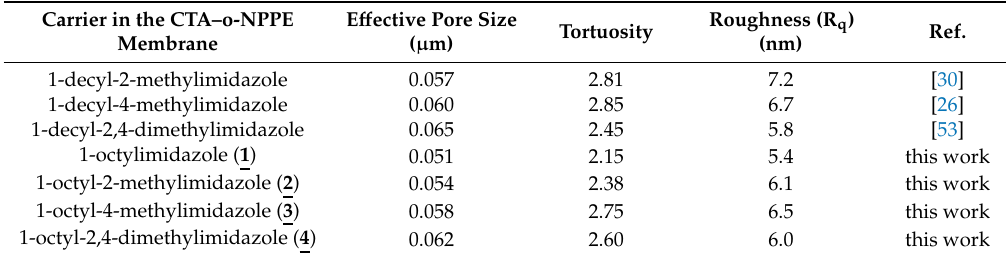
Table 1. AFM characterization parameters for PIMs doped with alkylimidazoles. CTA–o-NPPE is cellulose triacetate–o-nitrophenyl pentyl